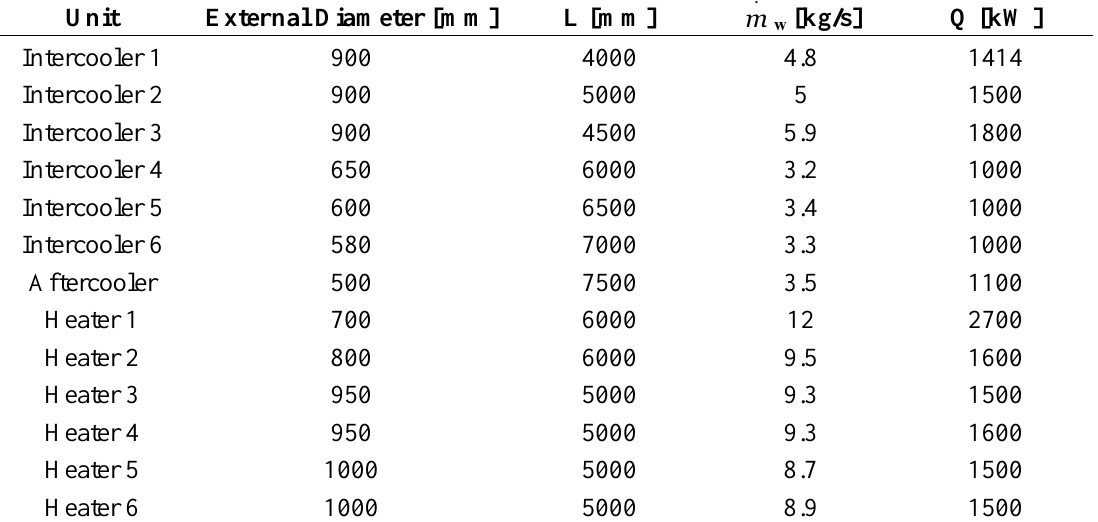
Table 2. Main data for CAES plant heat